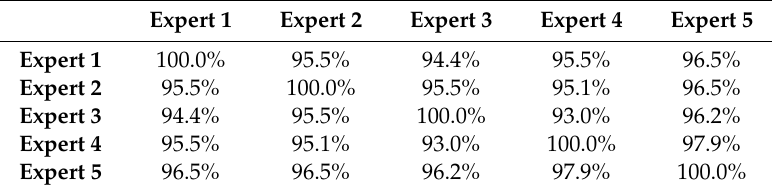
Table 2. Percentage agreement on either the primary or alternative outcome of treatment between di ff erent